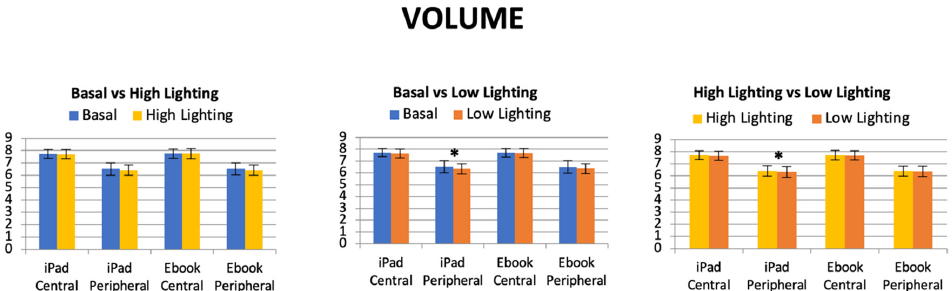
Figure 6. Mean and standard deviation (SD) of the central and peripheral retinal volume in high and low lighting conditions measured by 3D OCT-1000 after reading with both devices (iPad and Ebook). Differences that reached statistical significance ( p < 0.05) are marked with *.